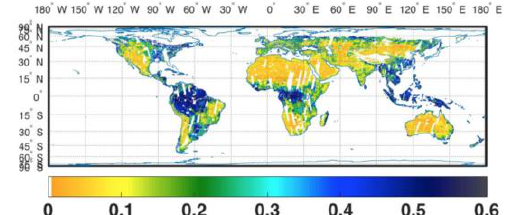
Figure 1: Soil moisture retrievals at 3 km spatial resolution from the SMAP and Sentinel-1A and -1B data between 1 th May 2017 and 12 th May 2017.